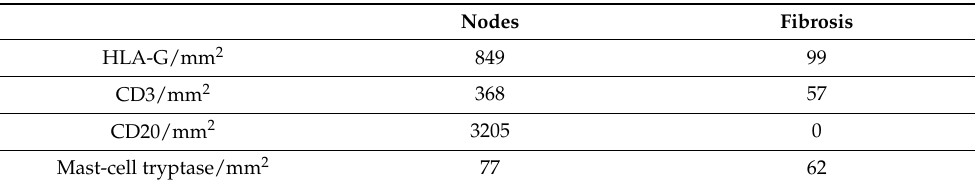
Table 4. Enumeration of HLAG + cells, T and B lymphocytes, and mast cells in two different areas of the liver (nodes and fibrosis).